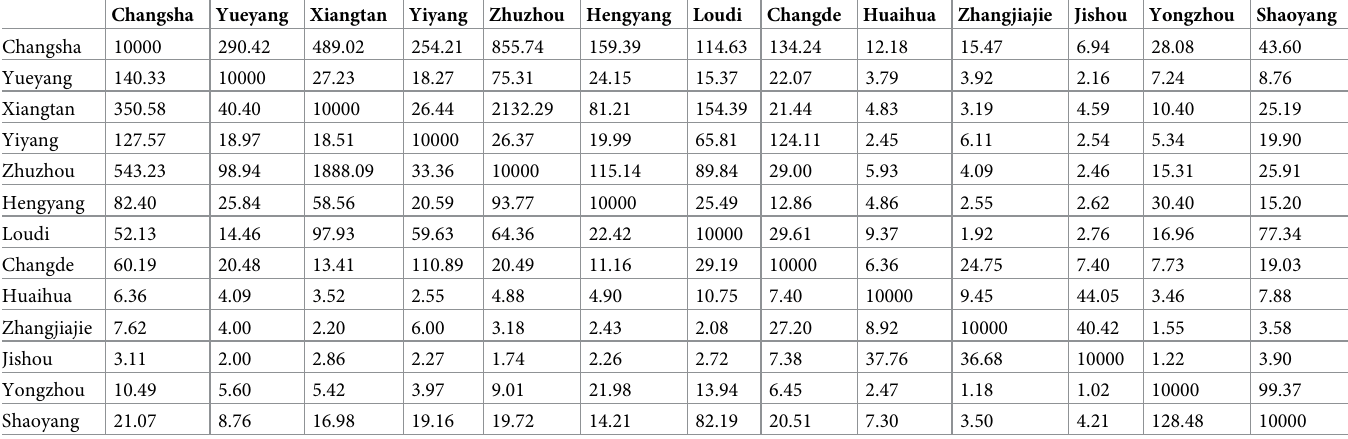
Table 3. The urban gravity matrix of cities in Hunan Province in the 2002